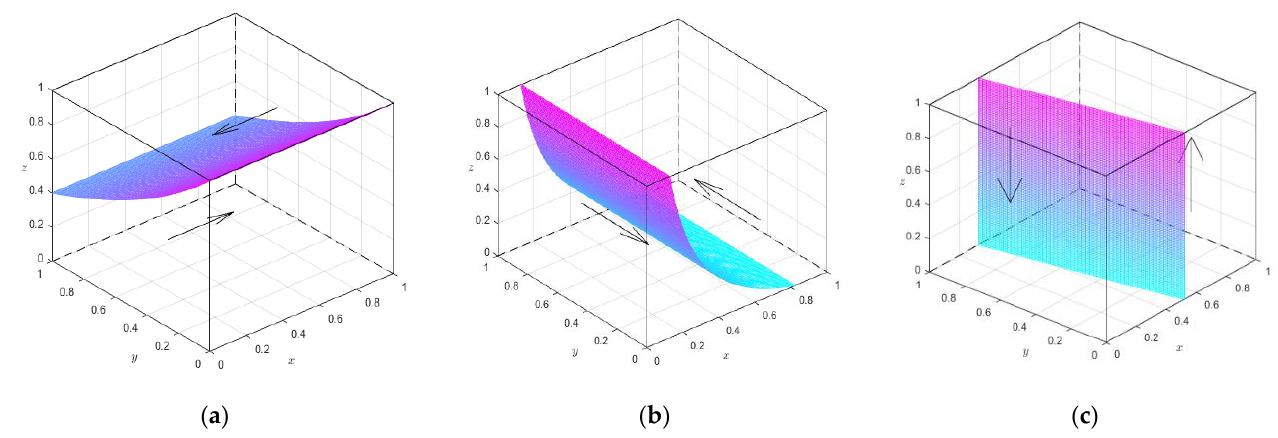
Figure 2. The phase diagram of the three stakeholders’ dynamic evolution: ( a ) description of the local governments’ dynamic evolution; ( b ) description of the local ATSOs’ dynamic evolution; ( c ) description of the farmers’ dynamic evolution. The arrow indicates the evolutionary direction of the initial stakeholders falling into the region where the arrow is